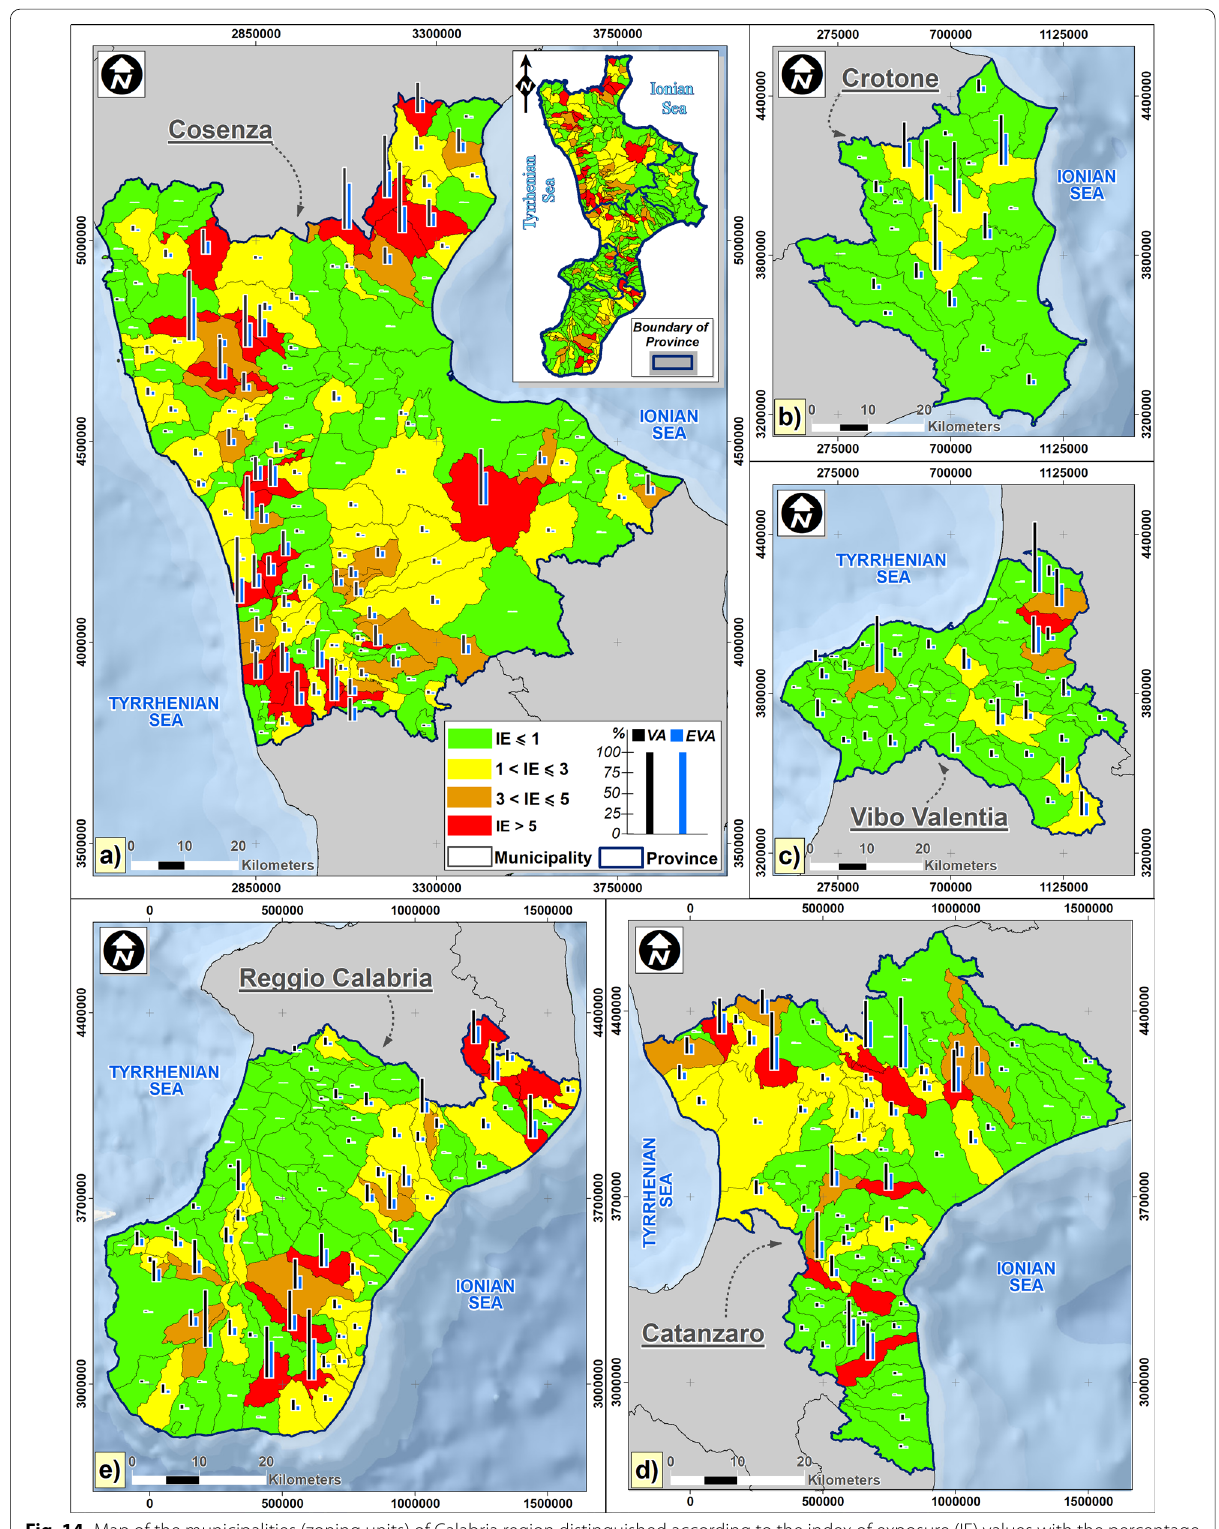
Fig. 14 Map of the municipalities (zoning units) of Calabria region distinguished according to the index of exposure (IE) values with the percentage of vulnerable area (VA) and Equivalent Vulnerable Area (EVA) for the Provinces of: a Cosenza, b Crotone, c Vibo Valentia, d Catanzaro and e Reggio